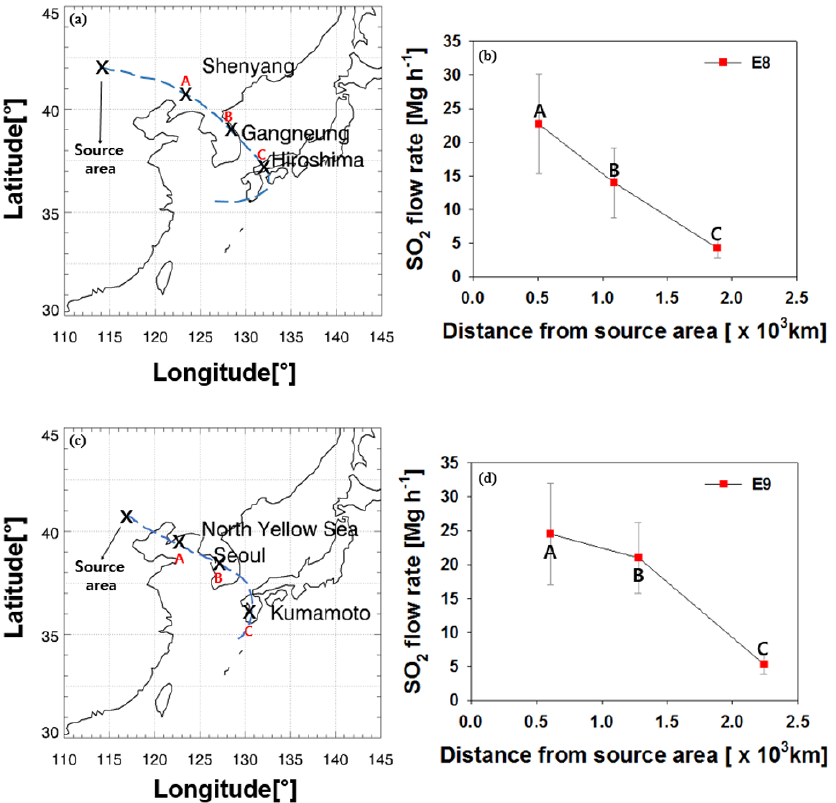
Figure 6. ( a ) air mass pathways for event E8; ( b ) LRT-SO 2 flow rate as a function of distance from the source area. A, B, and C in (a) and (b) correspond to Shenyang, Gangneung, and Hiroshima, respectively; ( c ) air mass pathways for event E9; ( d ) LRT-SO 2 flow rate as a function of distance from the source area. A, B, and C in (c) and (d) correspond to the North Yellow Sea, Seoul, and Kumamoto, respectively.